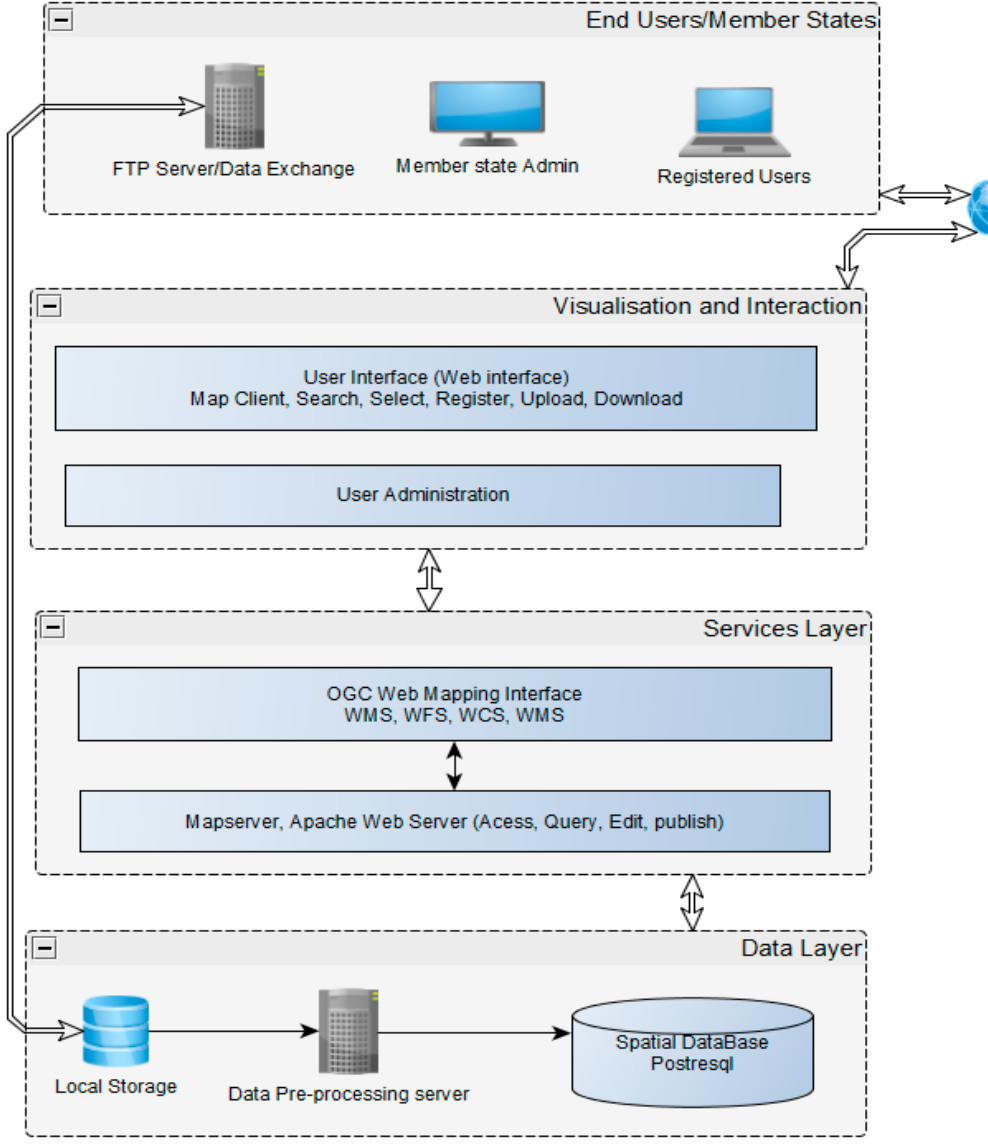
Figure 1. Application layers for the Agenda 2063 Geoportal. Three application layers were implemented for the geoportal.